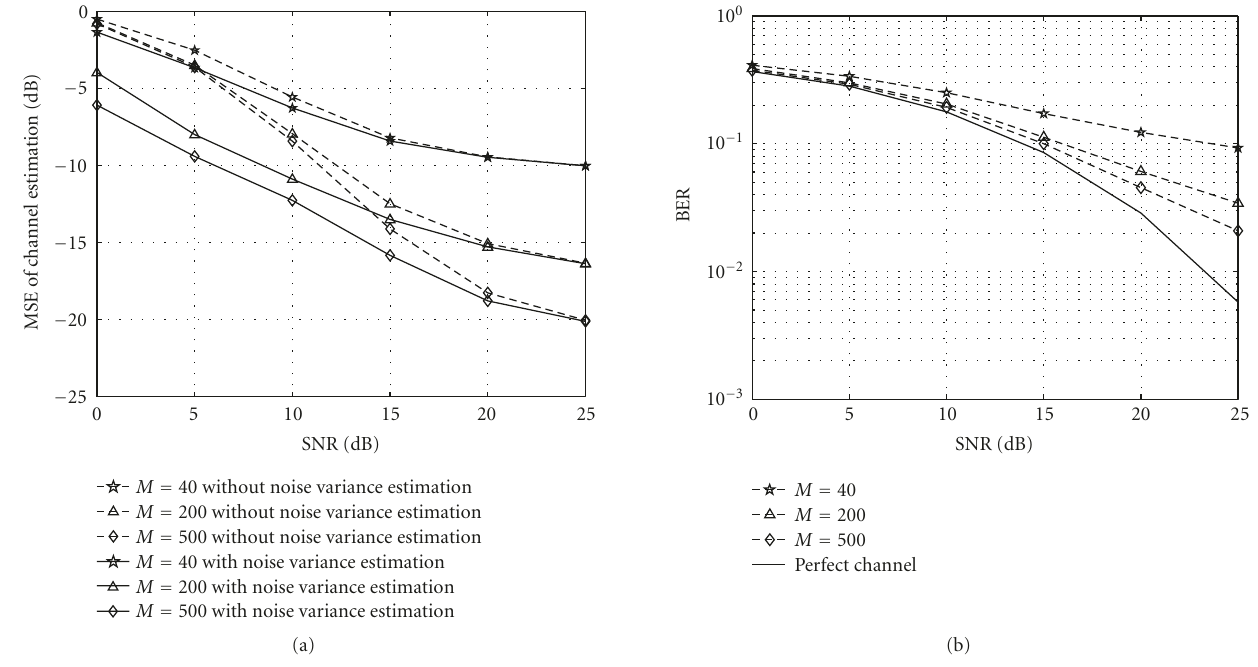
Figure 3: Example 1, synchronous two-branch transmission with a single receiver, N = L +1, data rate = 1, (a) normalized channel estimation MSE versus SNR, (b) BER versus SNR (with noise variance estimation).